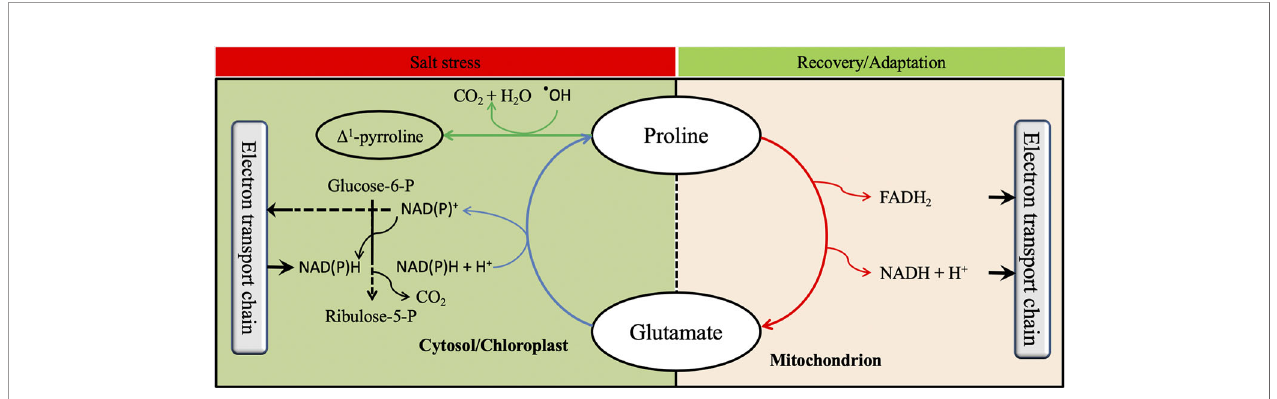
FIGURE 5 | Possible in fl uence of proline metabolism on physiological and biochemical processes. The oxidative pentose phosphate pathway is shown by black lines, the proline anabolic pathway with blue lines, the proline catabolic pathway with red lines, and proline scavenging reactive oxygen species with green